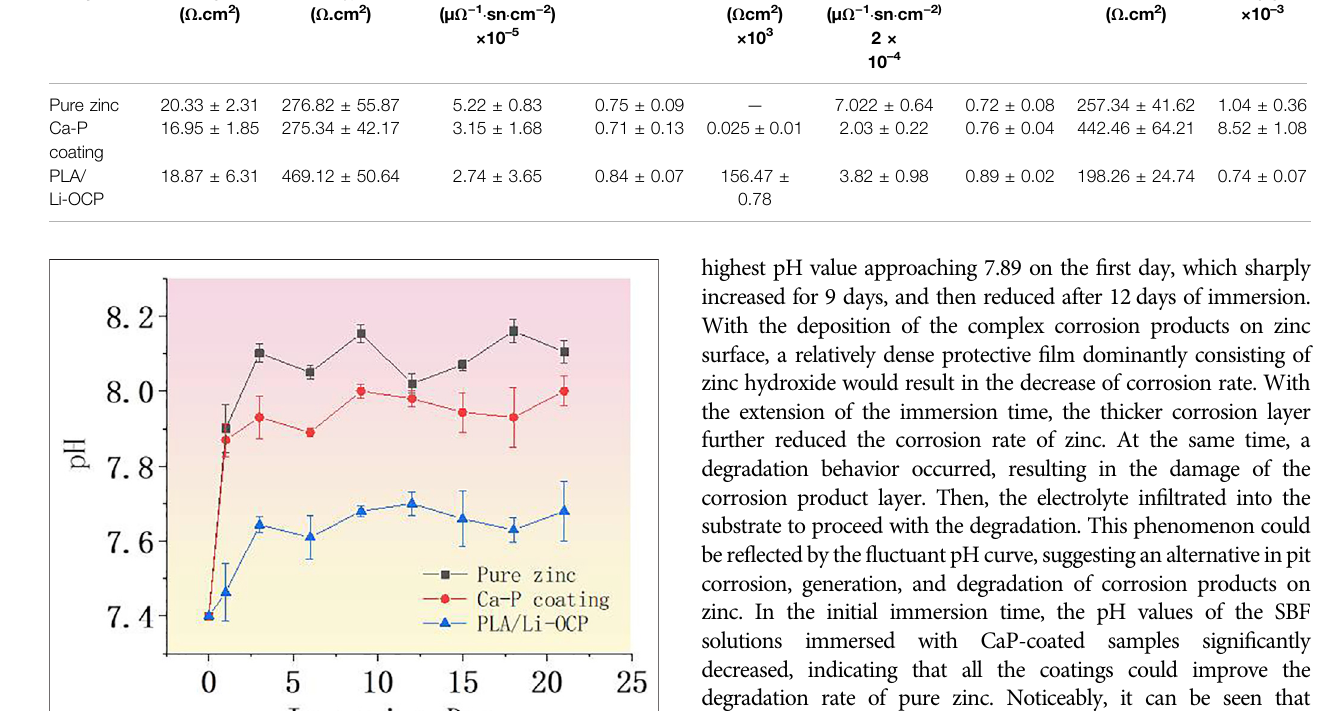
TABLE 3 | The corresponding results fi tted from the circuit element. Samples